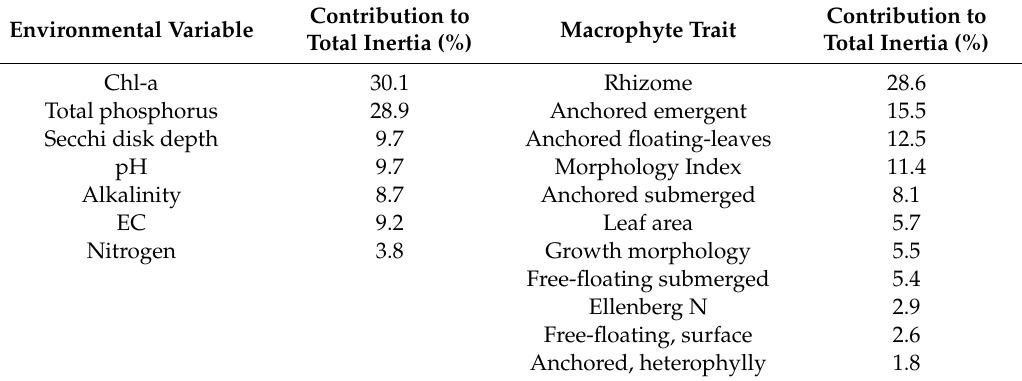
Table 5. Percentages of contribution of the environmental variables and functional traits to the RLQ